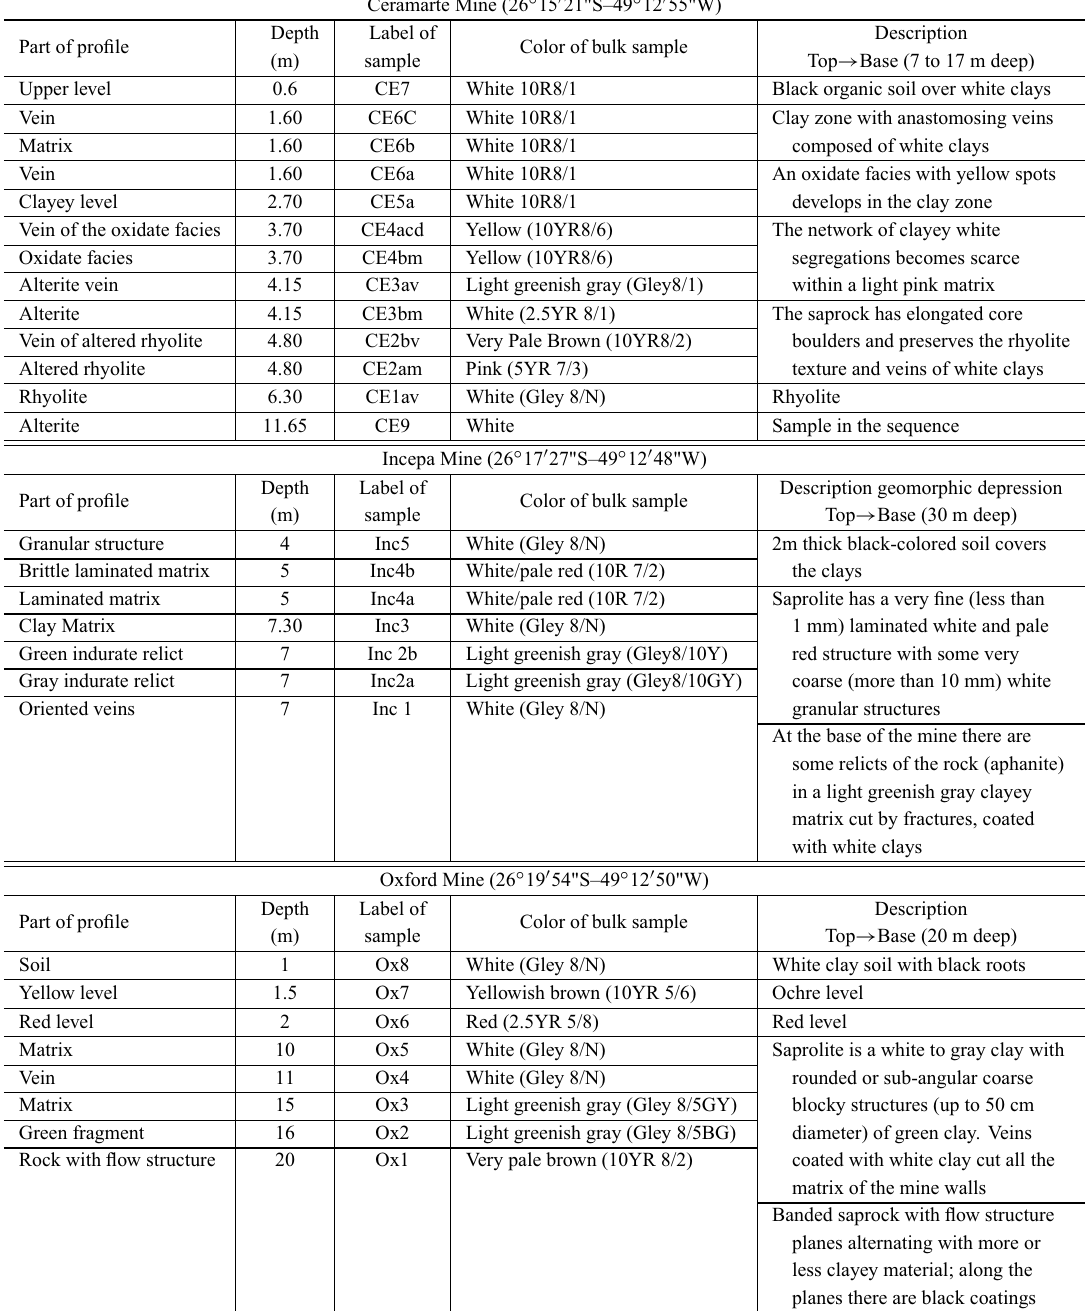
Visible differentiation from the walls of each mine, depth, label of the samples, color and description of the